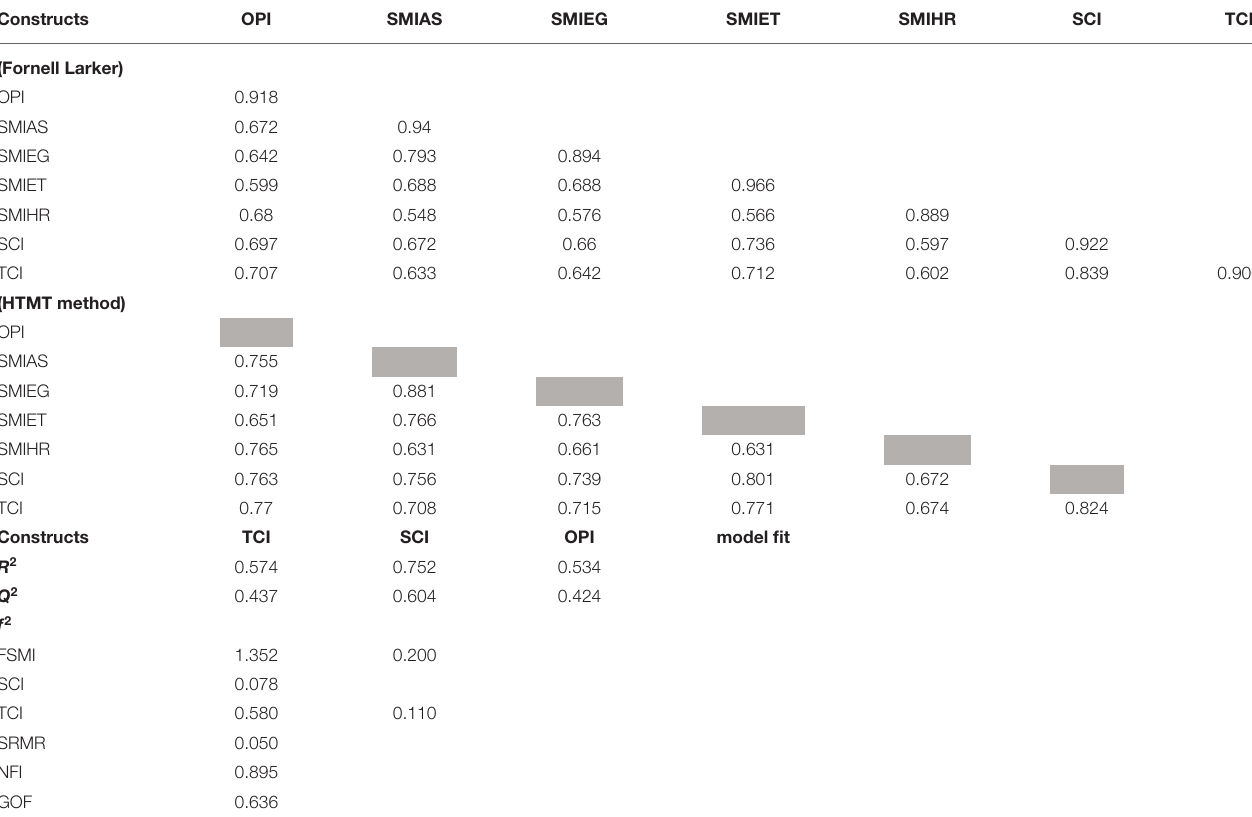
TABLE 4 | Discriminant validities, R 2 , Q 2 , f 2 and model fit.